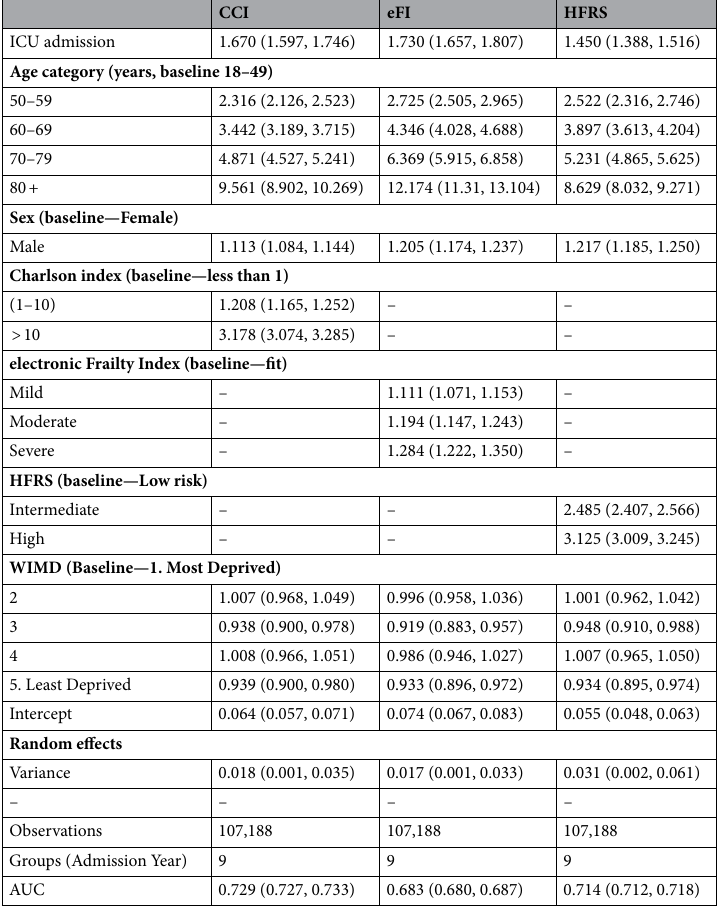
Table 3. Odds Ratios (ORs) for the adjusted multilevel multivariate logistic regression 6-month mortality analyses. ICU Intensive Care Unit; CCI Charlson Comorbidity Index; eFI electronic Frailty Index; HFRS Hospital Frailty Risk Score; WIMD Welsh Index of Multiple Deprivation 2019; AUC Area Under the